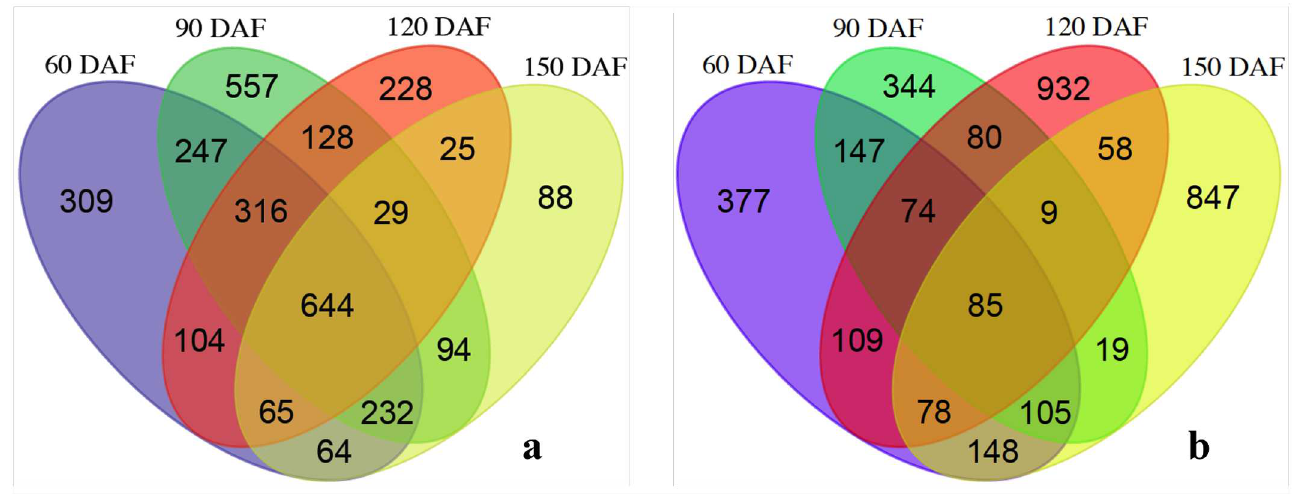
Fig 1. Venn diagrams showing unigenes up- (a) and down-regulated (b) among perisperm development stages (60, 90, 120 and 150 DAF) compared with perispermat 30 DAF. A total of 3,130 unigenesclassified as down-regulated ( a ) and 3,412 unigenesclassifiedas up-regulated ( b ) were used in this